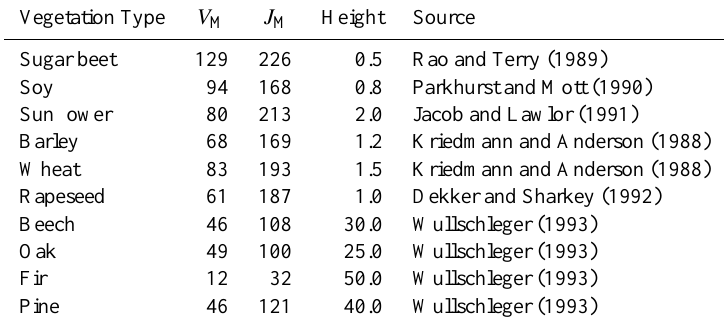
Table 2. Additional vegetation types of the BETHY/DLR model with vegetation parameters (after Knorr, 1997). V M : maximum